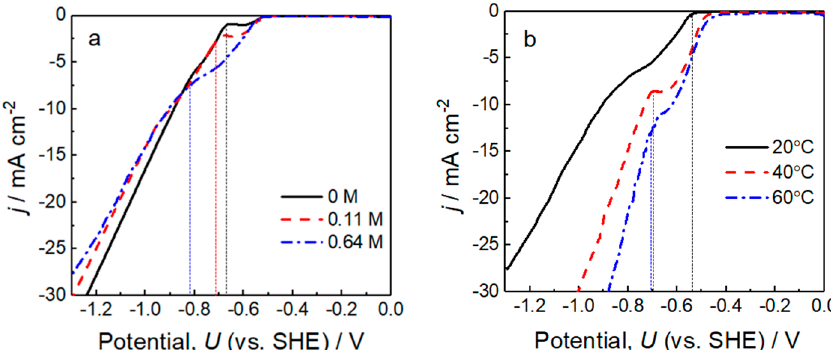
Figure 1. Cathodic polarisation curves of the Fe-P alloys electrodeposition depending on ( a ) the glycine concentration Gly at 20 °C and ( b ) the bath temperature at 0.64 M Gly.